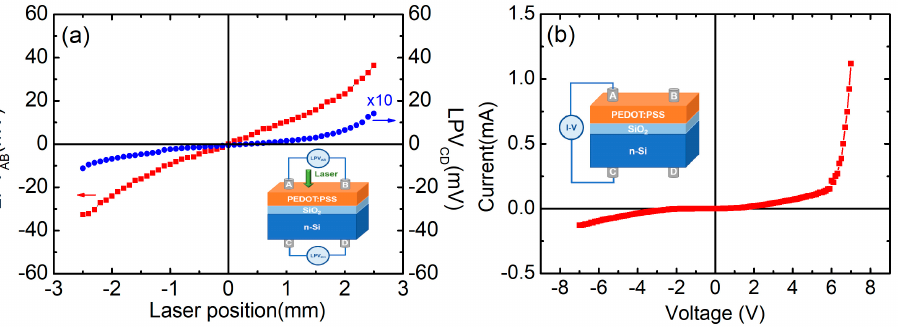
Figure 1. ( a ) The LPV dependence of laser position in the Si/SiO 2 /PEDOT:PSS; ( b ) I-V curve of the Si/SiO 2 /PEDOT:PSS. The schematic diagrams of the devices are shown in the